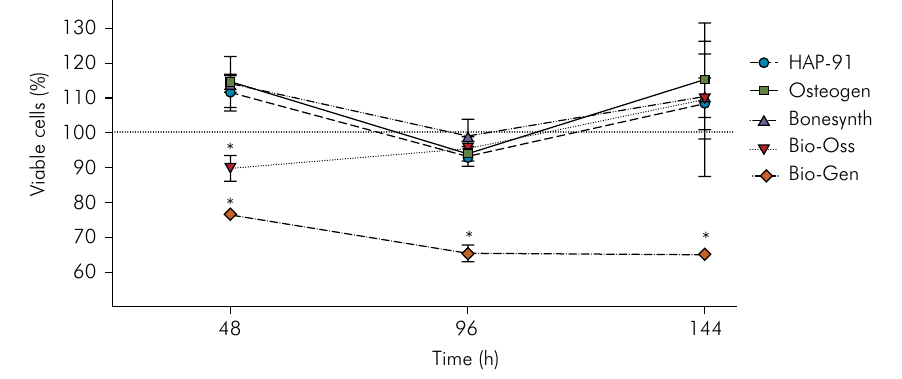
Figure 3. Cell viability/proliferation of MC3T3-E1 cells cultured in media conditioned with each HA and evaluated at three-time intervals (48, 96, and 144 h). *Significant differences between natural and synthetic